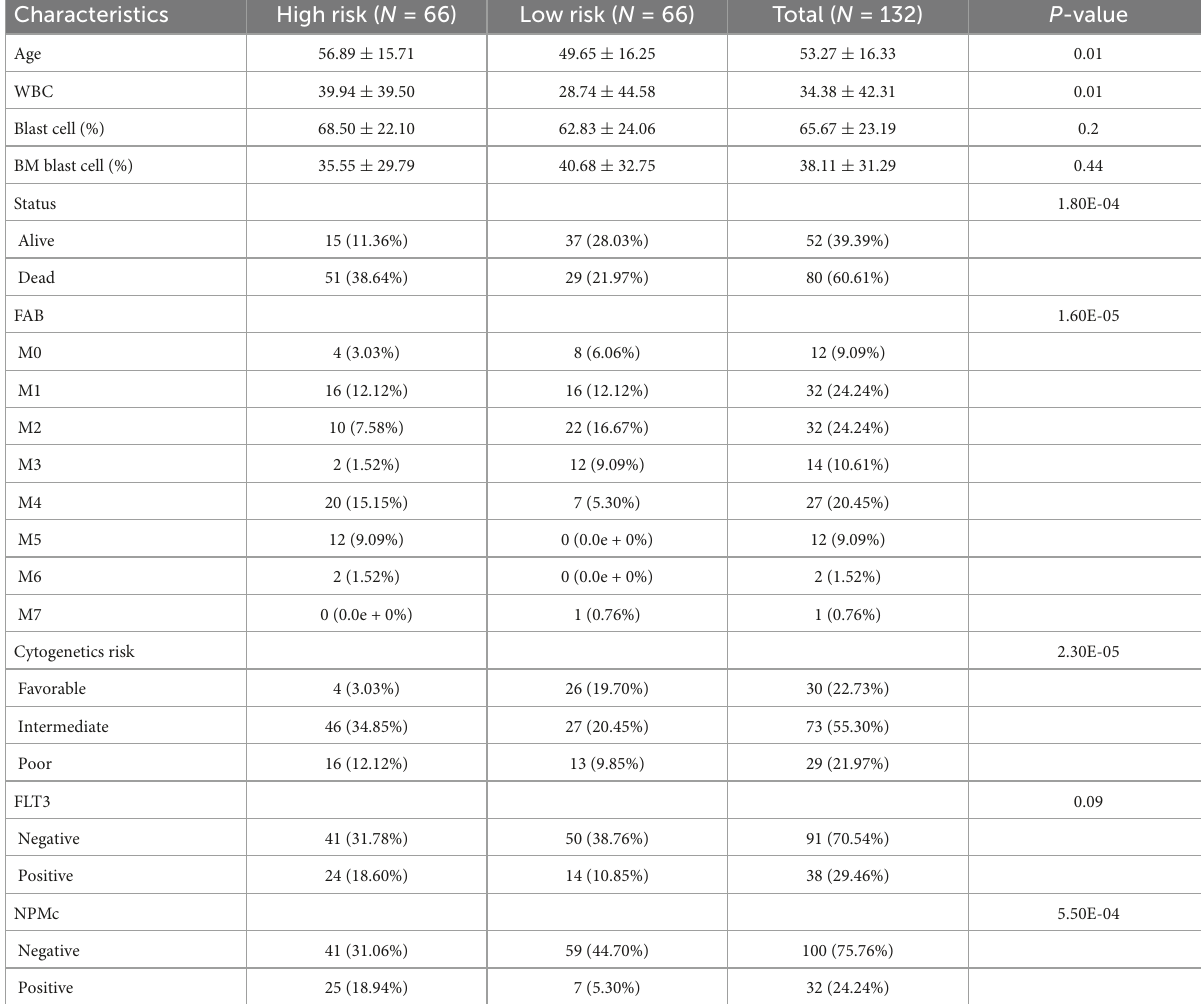
TABLE 2 The characteristics of 132 acute myeloid leukemia (AML) patients between different risk group.